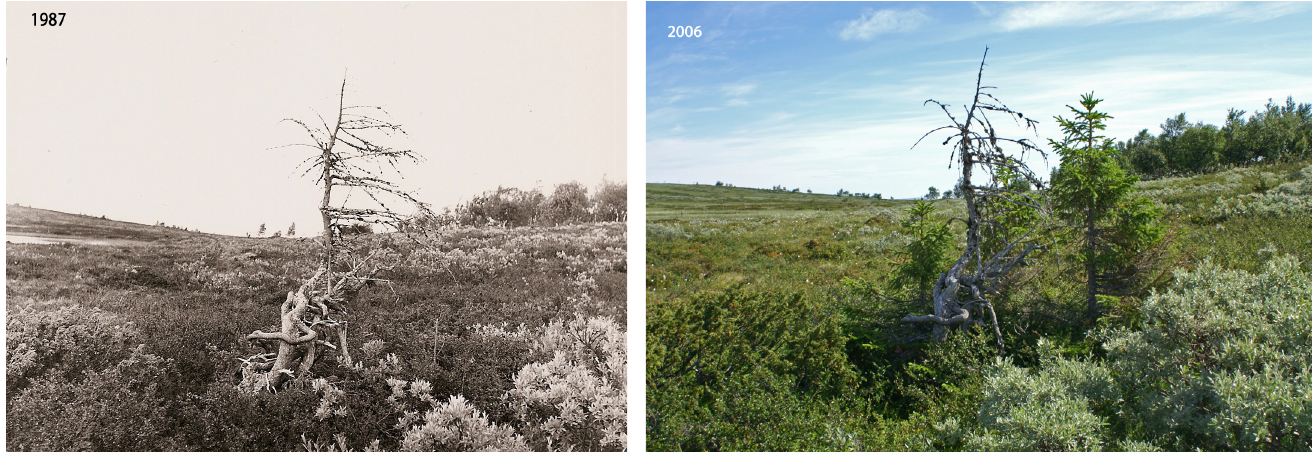
Figure 24: Left. Subalpine spruce which suffered almost complete defoliation (frost desiccation) during cold winters of the 1970s. 14 July 1972. Right. During the past few decades it has recovered substantially by emergence of new stems from old root stocks. 16 July